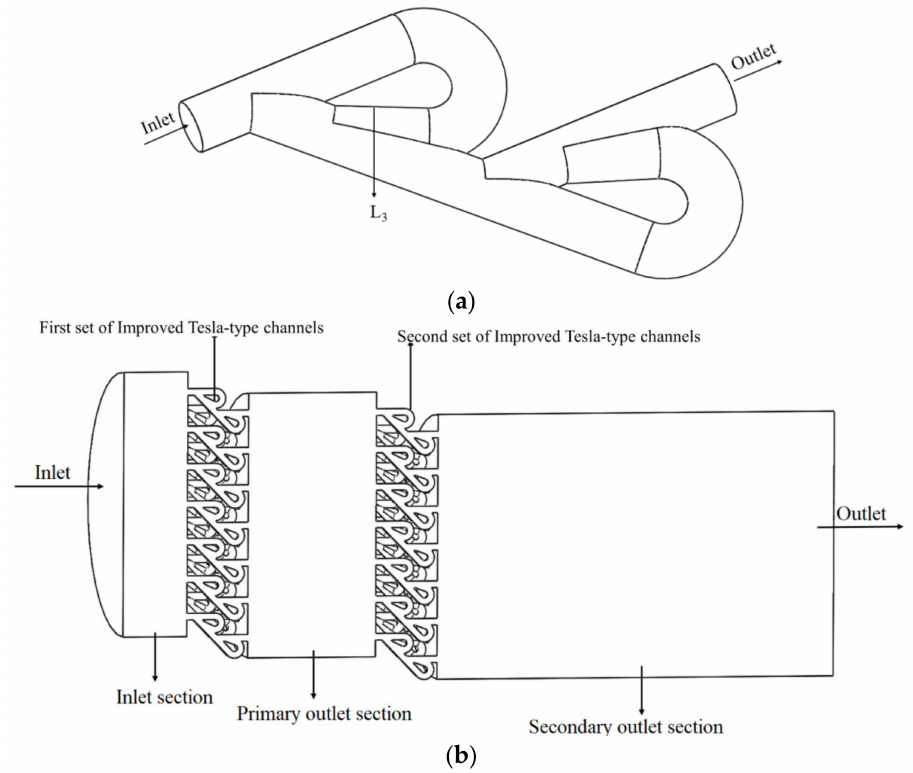
Figure 13. Improved Tesla-type channel and two-stage Tesla-type orifice structure. ( a ) Improved Tesla-type channel. ( b ) Two-stage Tesla-type orifice